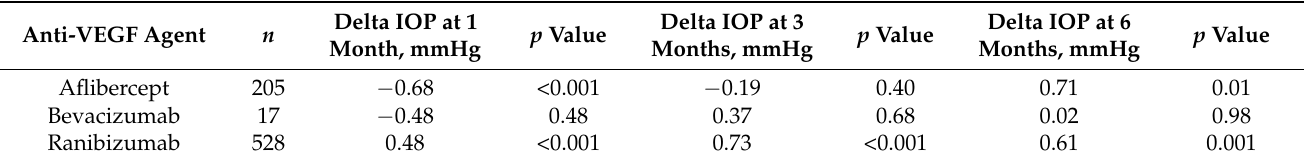
Table 2. Intraocular pressure variation in treated eyes compared with untreated fellow